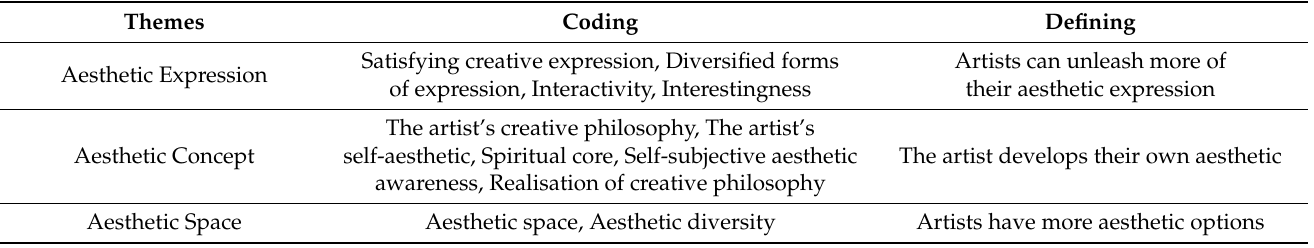
Table 2. Aesthetic needs, coding themes, and defining results.